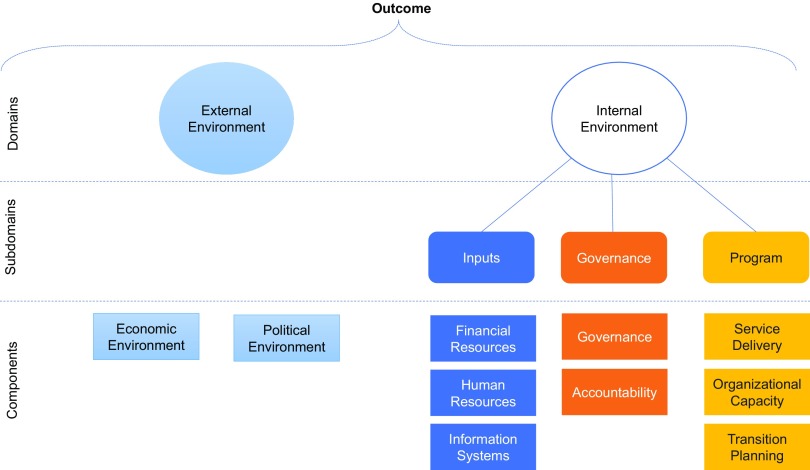
Transition Preparedness Assessment Framework and ComponentsSource: Amaya AB et al. (2015).33